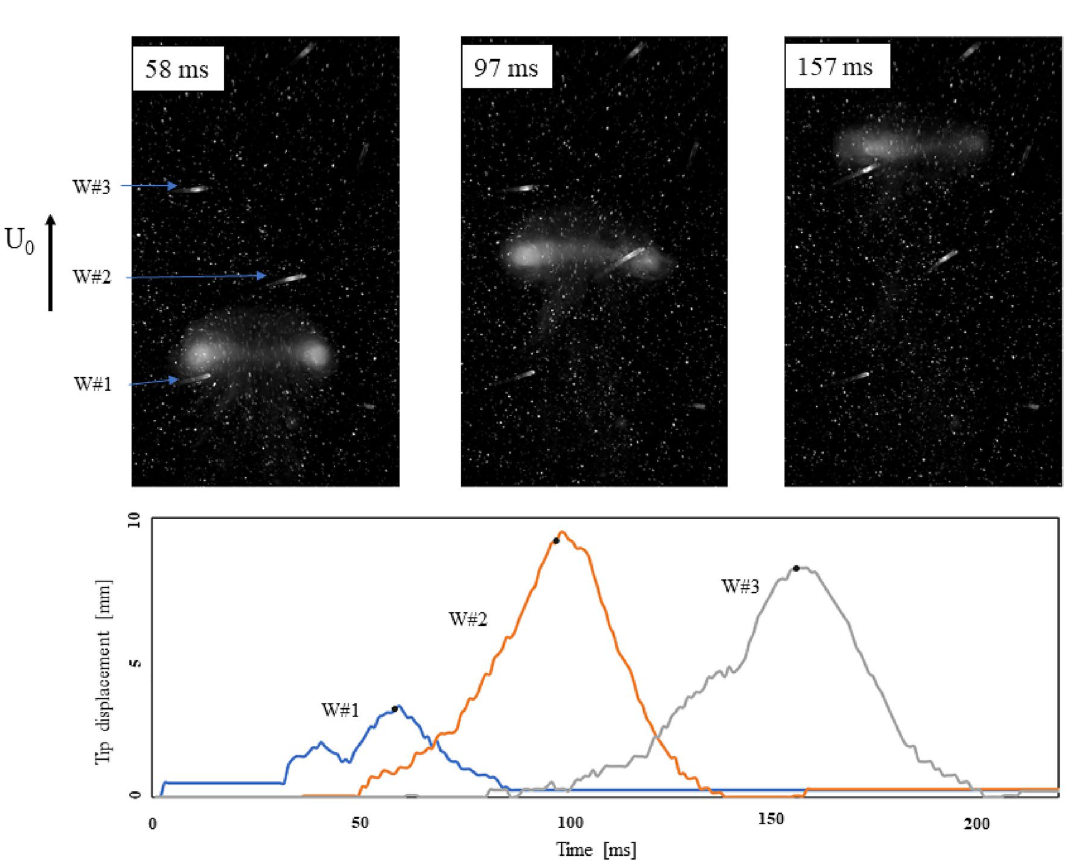
Figure 7. Top: Vortex ring propagating across the array. Bottom: Whisker tip tracking data matches the visualisation of the vortex